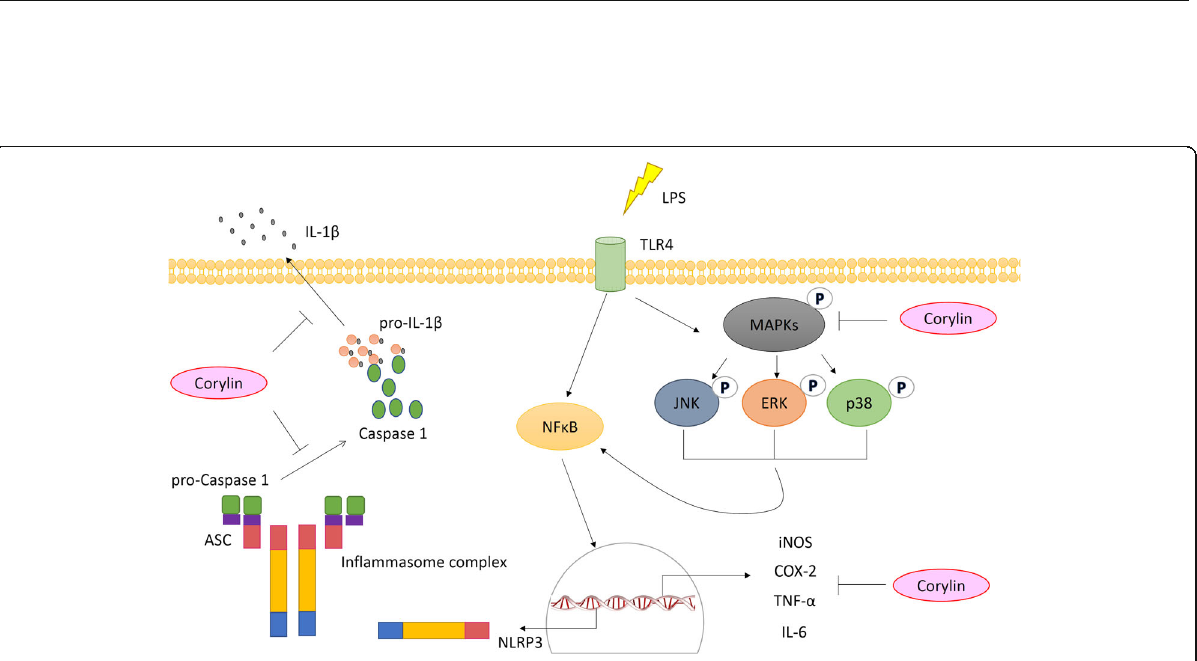
Fig. 6 The potential mechanisms of corylin in suppression of LPS-induced inflammation and NLRP3 activation in microglia